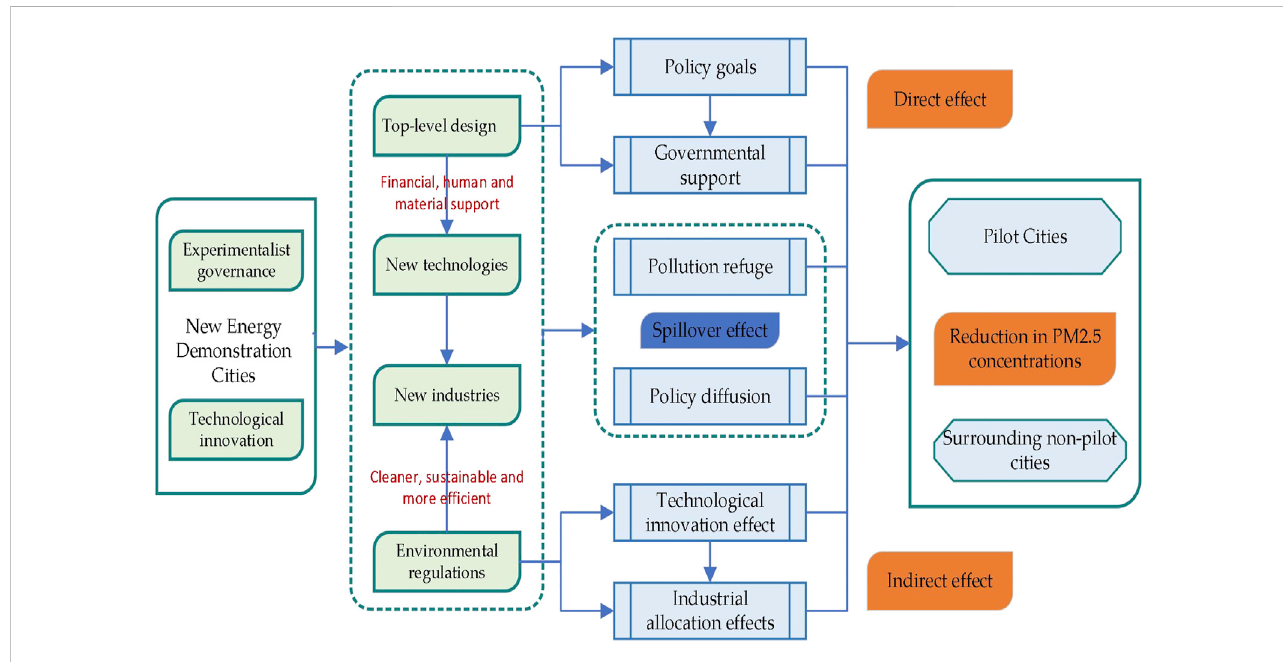
FIGURE 3 Theoretical framework for the effect of NEDC policy on